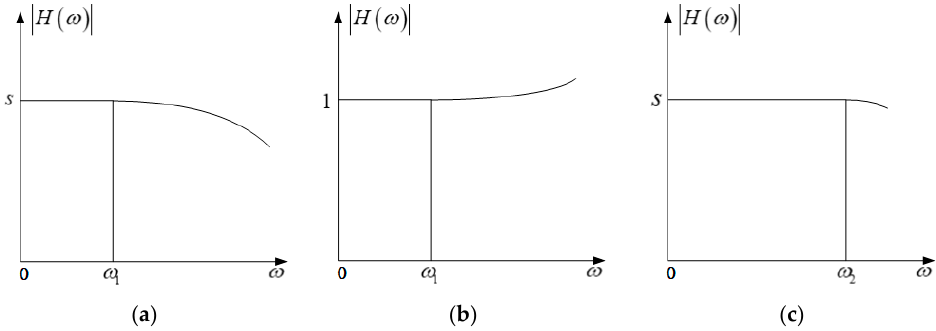
Figure 6. Diagram of amplitude–frequency characteristic curves before and after dynamic compen- sation: ( a ) magnetometer; ( b ) compensation link; ( c ) after compensation. Considering that the factors and mechanisms affecting the dynamic characteristics of the magnetic sensor are complex, this paper selects system identification and modeling methods to solve the parameters of the dynamic compensator. The dynamic response of the sensor is taken as the input of the dynamic compensator, and the measured signal is taken as the output of the dynamic compensator. The parameters of the dynamic compen- sator are solved by the optimization algorithm to realize the modeling of the dynamic compensator. The basic schematic diagram is shown in Figure 7.